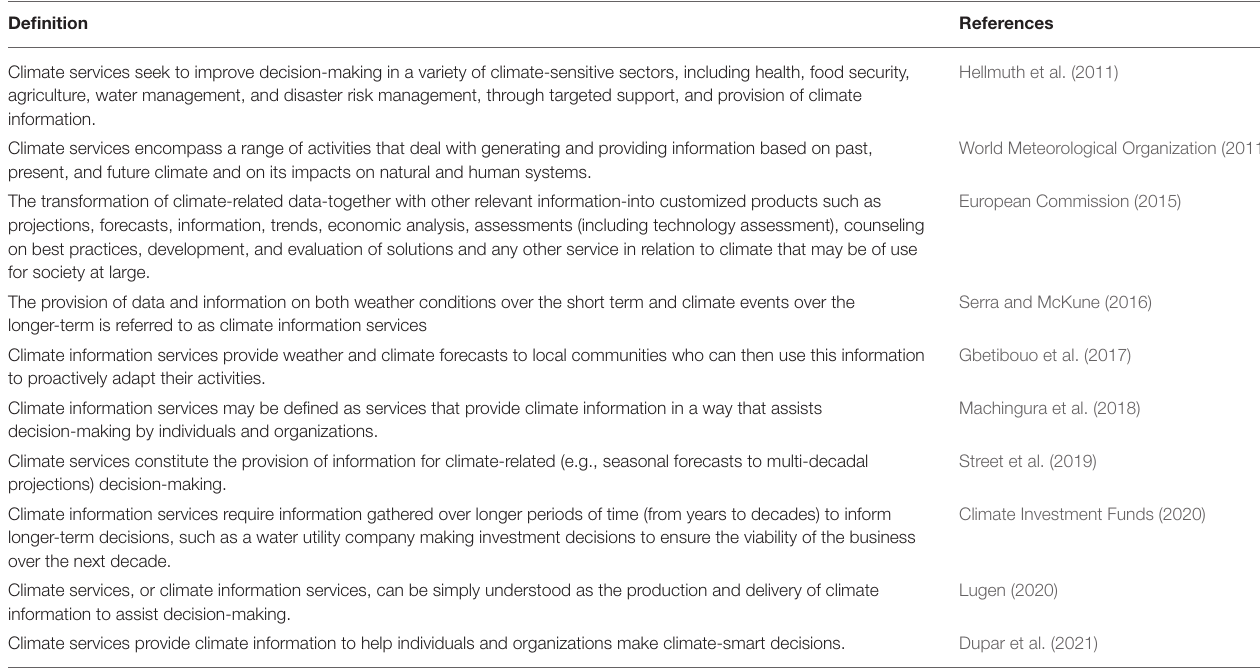
TABLE 1 | Definitions of climate information services/climate services in